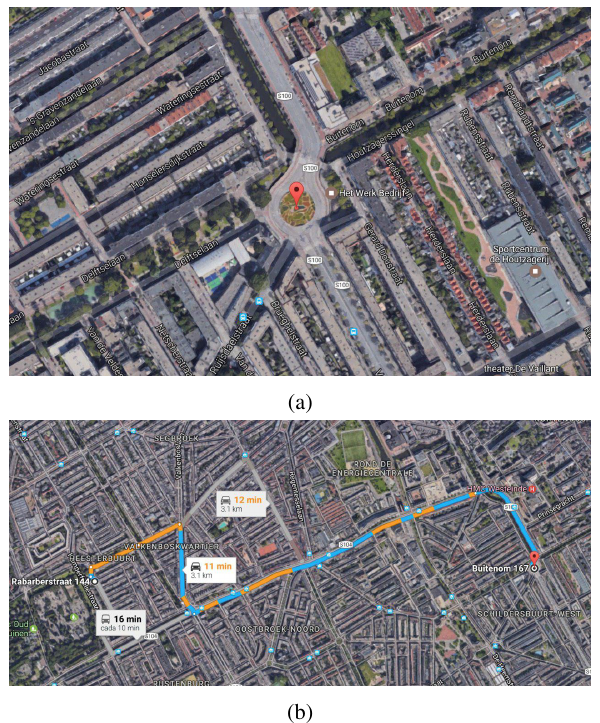
Figure 10. Wrong georeferencing of IFC models. (a) Provided position of the Rabarberstraat 144. (b) Distance comparison be- tween the provided and the real positions. Images and map data taken from Google